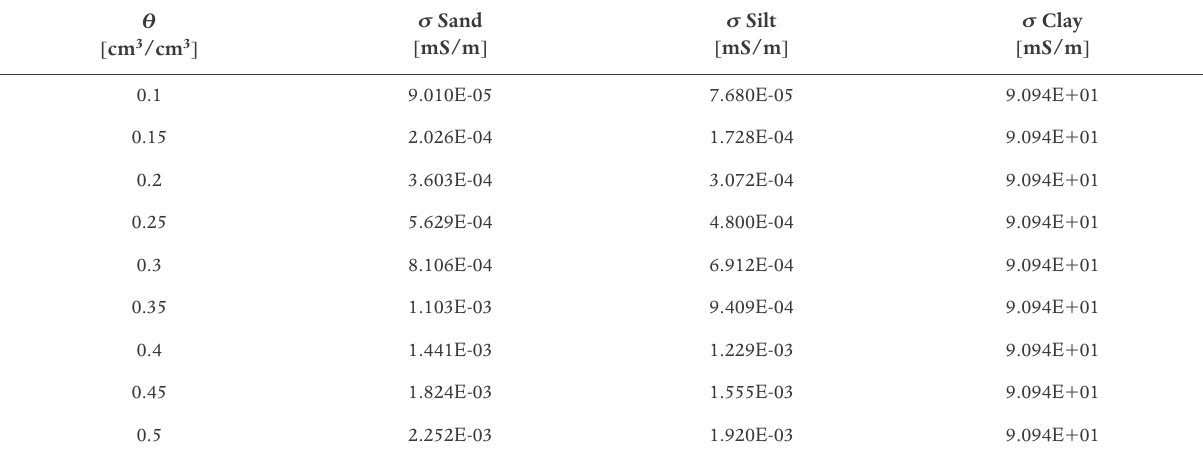
Table 4. Electrical conductivity and corresponding SWC values according to Archie